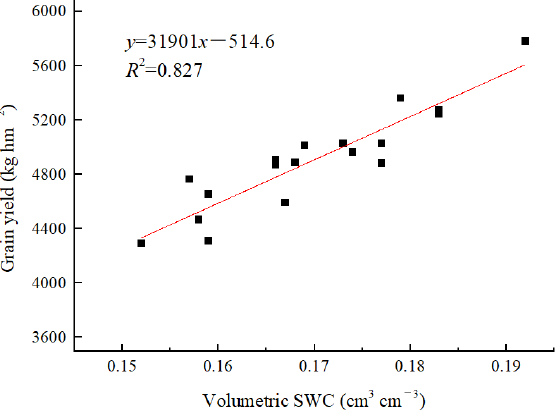
Figure 5. Relationship between pre-seeding volumetric soil water content (SWC) in the top 30 cm profile and in-season maize grain yield. Table 5. ANOVA of the maize grain yield in line with the diverse treatments from 2016 to 2018. Y: year; T: treatments; Y × T: interaction influence of treatment and year. ** indicates significant difference at p = 0.01 level. Variation Source Degree of Freedom Mean Square F